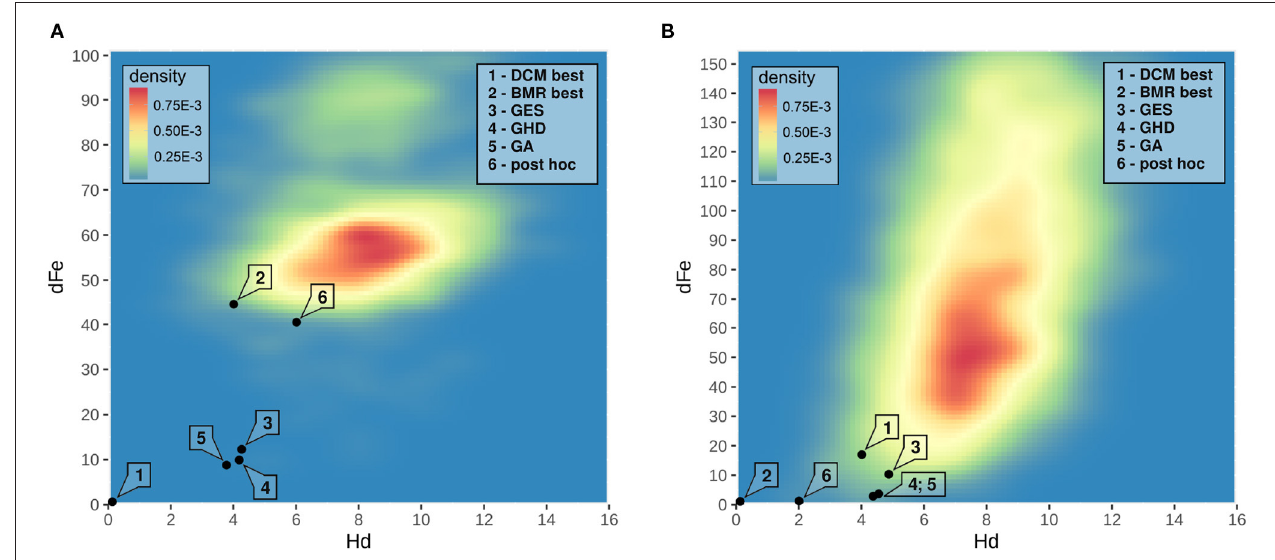
FIGURE 5 | The joint distribution density of dFe and Hd of an example subject. Joint density images reveal any topological structure over the model-space by characterizing the distance between graph structure, as scored with the Hamming-distance, in terms of differences in model evidence or free-energy. The joint density for the model-space estimated by DCM is shown on (A) , and the distribution in the BMR space on (B) . In cases where there are no relationship between topological structure and model evidence, the joint distribution would look more evenly distributed over Hd in any range of dFe. In this shown example model structure appears to be correlated to model evidence by r = 0.33 in the DCM model-space and by r = 0.68 in the BMR space. This reflects the assumption of Pyka et al. (2011), being models with higher Fe are also close to the topological structure of the best model. On the (0,0) coordinates the best model of their corresponding space can be found. Model search results are labeled according to their description. As the Bayesian post-hoc model selection is not available in the fully estimated DCM model-space, we indicated the model with the same ID on both